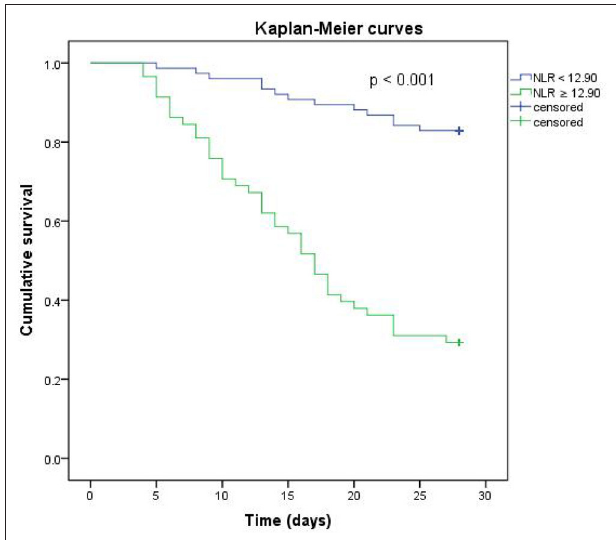
FIGURE 3 | Kaplan-Meier analysis of NLR on the 4th day. The blue line represents NLR < 12.90. The green line represents NLR ≥ 12.90.